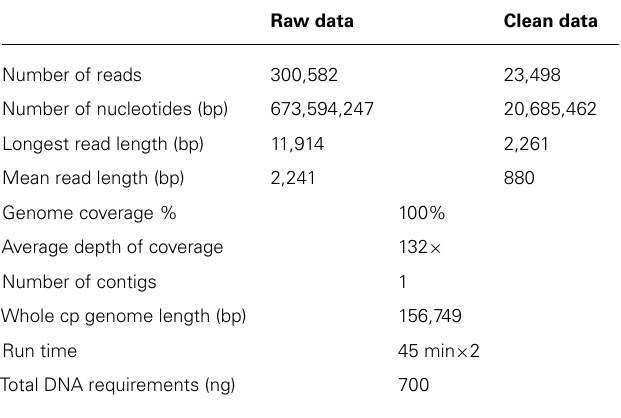
Table 1 | Summary of the sequencing data for PacBio